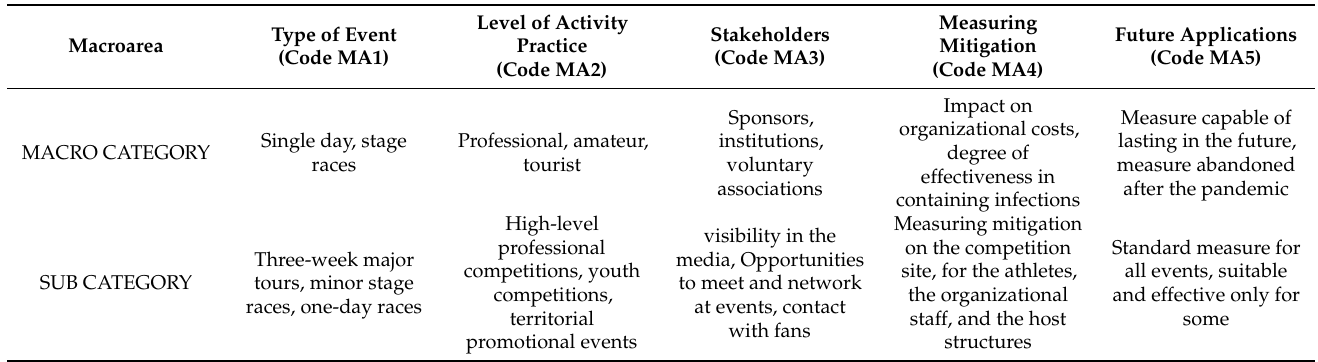
Table 2. Processing data